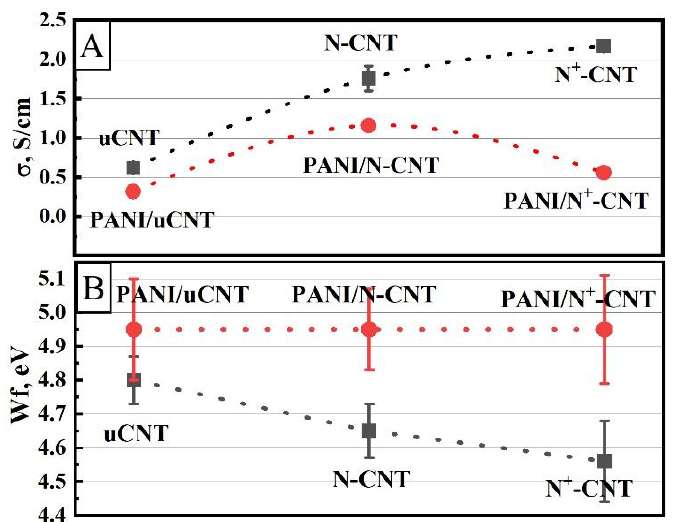
Figure 5. Conductivity ( A ) and work functions ( B ) of uCNT, N-CNT, N + -CNT and PANI/uCNT, PANI/N-CNT, PANI/N + -CNT composites.